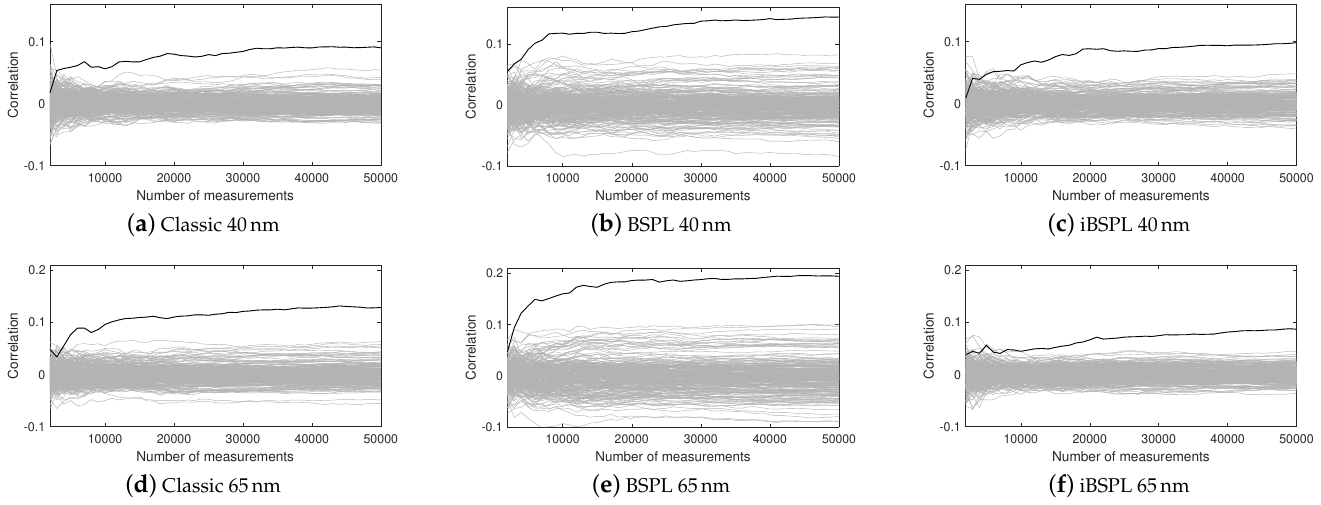
Figure 13. MCDPA attack on 50,000 simulated dynamic power traces for random input